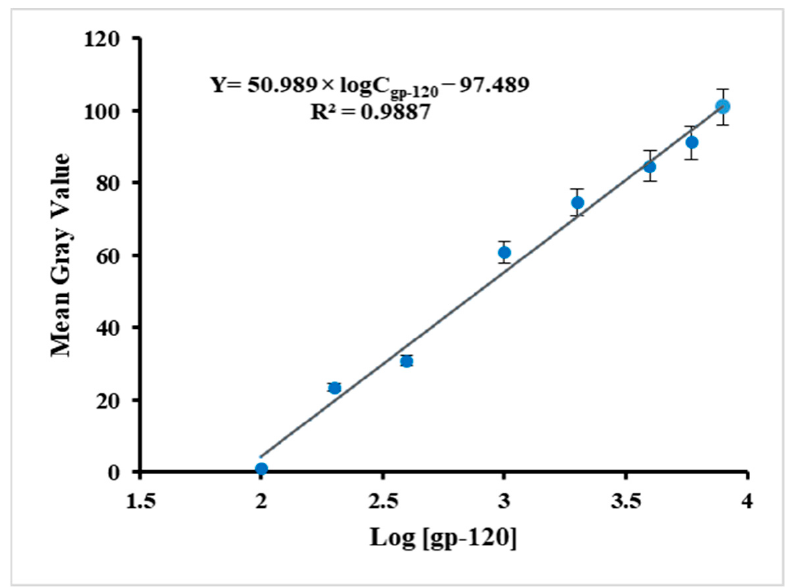
Figure 8. Calibration curve of the mean gray values of LC optical images and the logarithm of the gp-120 concentration (Y = mean gray value of the optical images and C gp-120 = concentration of gp-120 (ng/mL)).